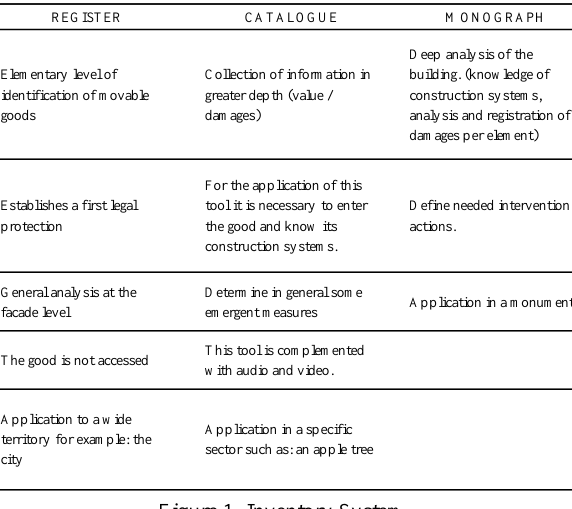
Figure 1. Inventory